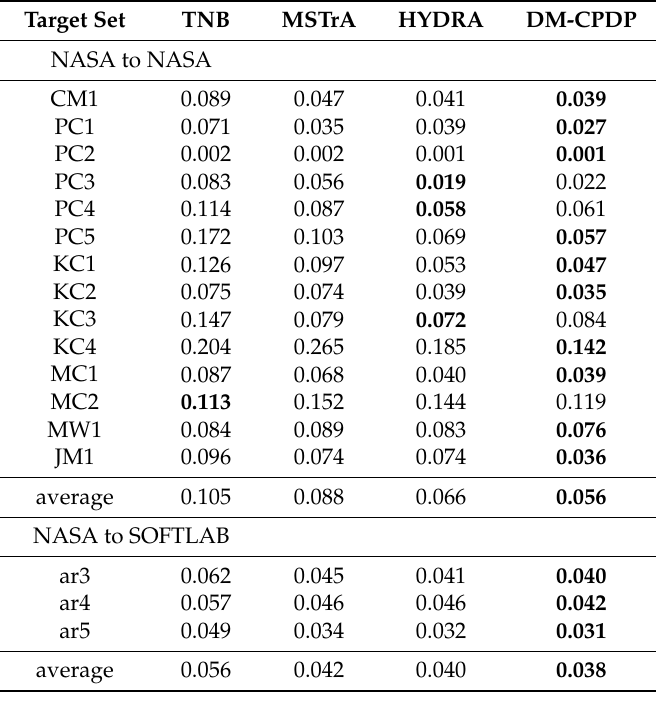
Table 6. Comparison of performance indicators